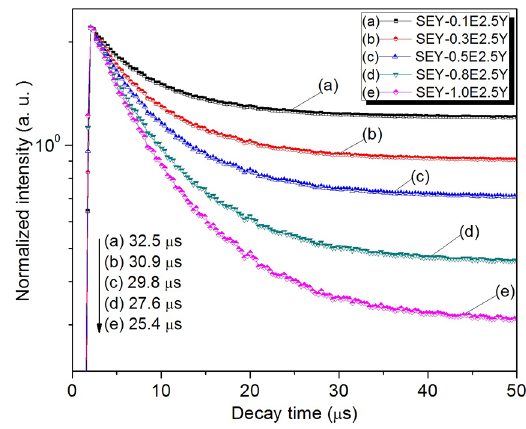
→ 2 F under excitation 5/2 7/2